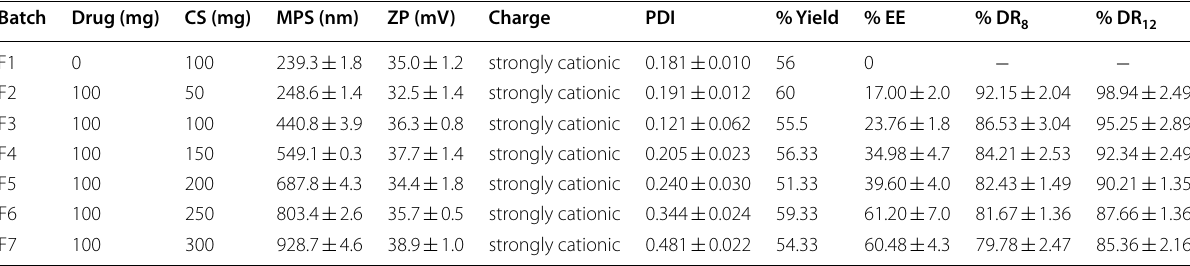
Mean particle size (nm), Polydispersity index (PDI), Zeta Potential (mV), % Drug entrapment efficiency (EE), % Drug Release at 8 h., and % Drug Release at 12 h. Mean SD. N 3 ± =